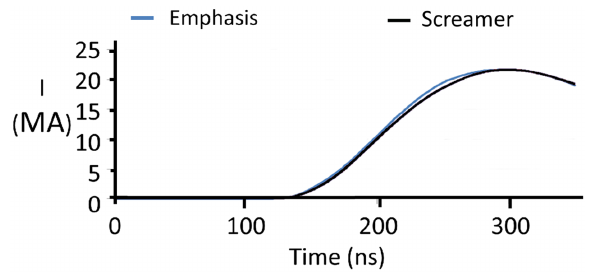
FIG. 13. Forward going ( V ) and reflected ( V ) FIG. 15. Load currents for Emphasis and Screamer simula- injected reflected voltages at the OTL2 monitor position for the upper (U) and tions of the standard four-level MITL-PHC configuration with a lower (L) levels from the Emphasis and Screamer simulations. 5 nH